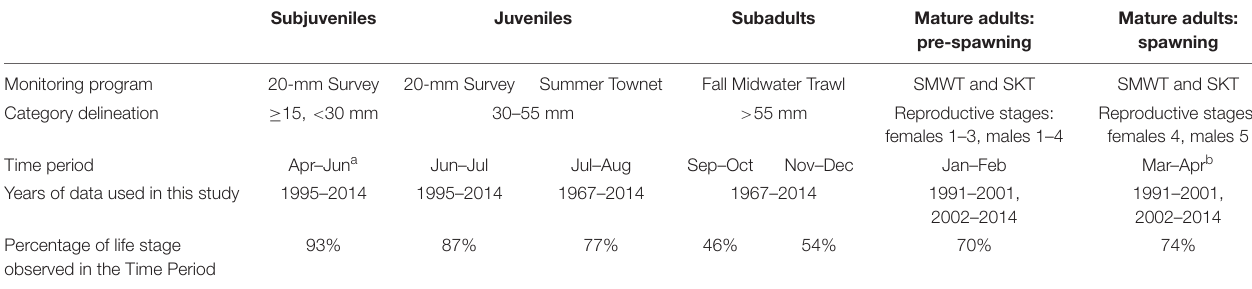
TABLE 2 | Delineation of the life stages used to examine delta smelt performance.